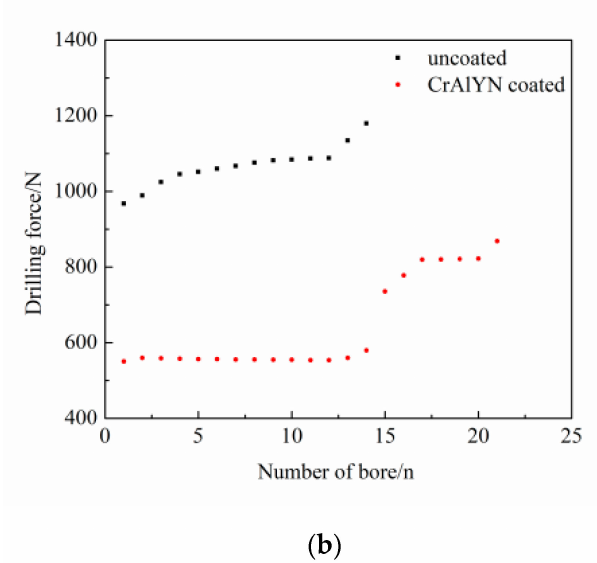
Figure 6. Comparison of drilling force between uncoated and coated bits (drilling depth of 6 mm and drilling feed rate of 0.04 mm/r). ( a ) Drilling force at a drilling speed of 15 m/min. ( b ) Drilling force at a drilling speed of 20